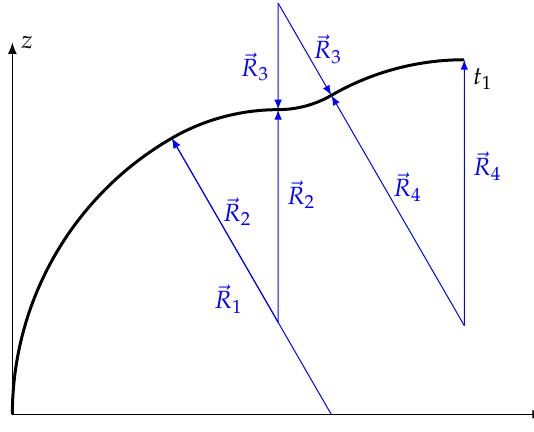
Figure 3. Approximation to the trajectory of a rocket by arcs of constant